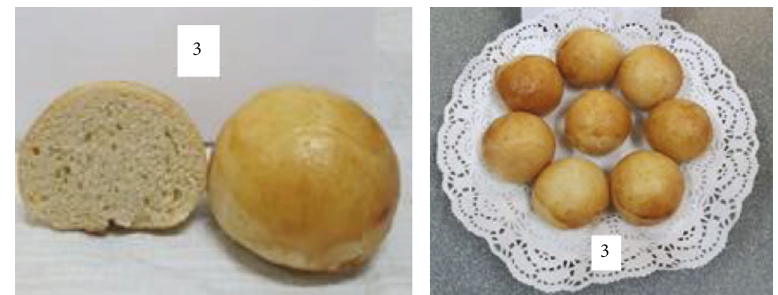
Figure 4: Sample no. 3 with 40g of sugar beet powder added.